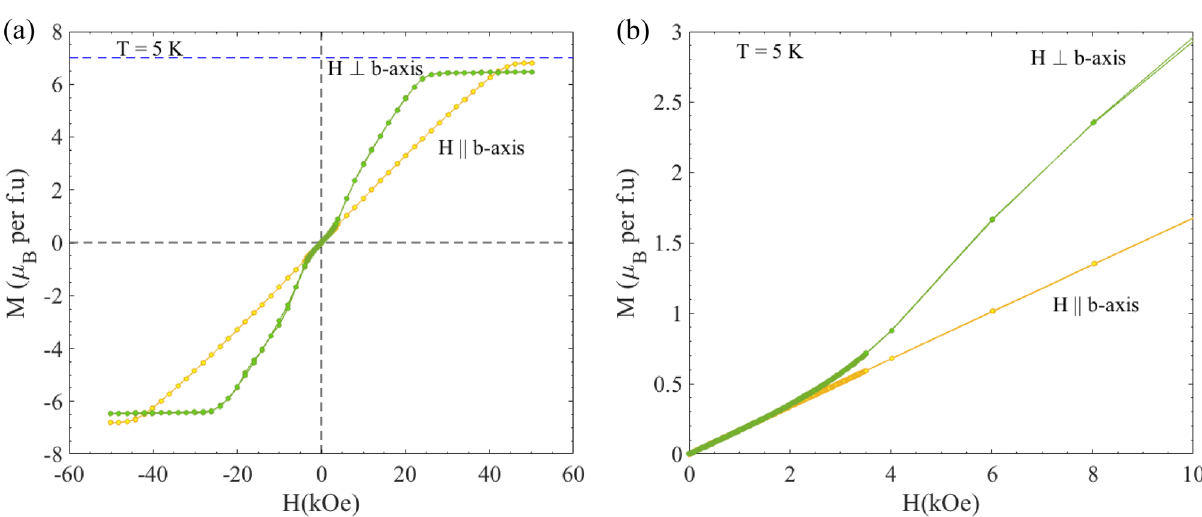
Figure 7. ( a ) M(H) curves for GdAu 6.75−x Al 0.5+x recorded at a constant temperature T = 5 K for H ⊥ b -axis and H ∥ b -axis. ( b ) Zoomed view of ( a ) to observe the change in linearity for H ⊥ b -axis at low fields. To clearly